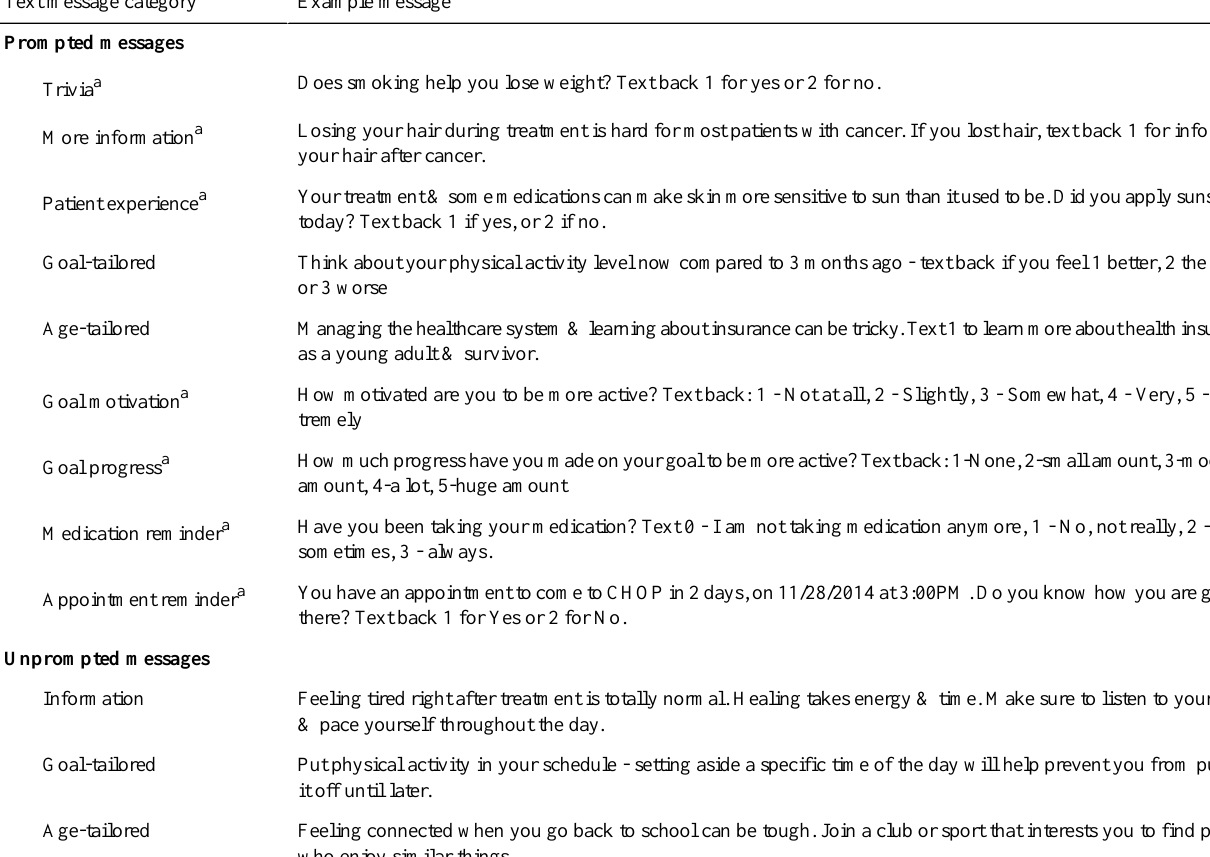
Example messageText message category